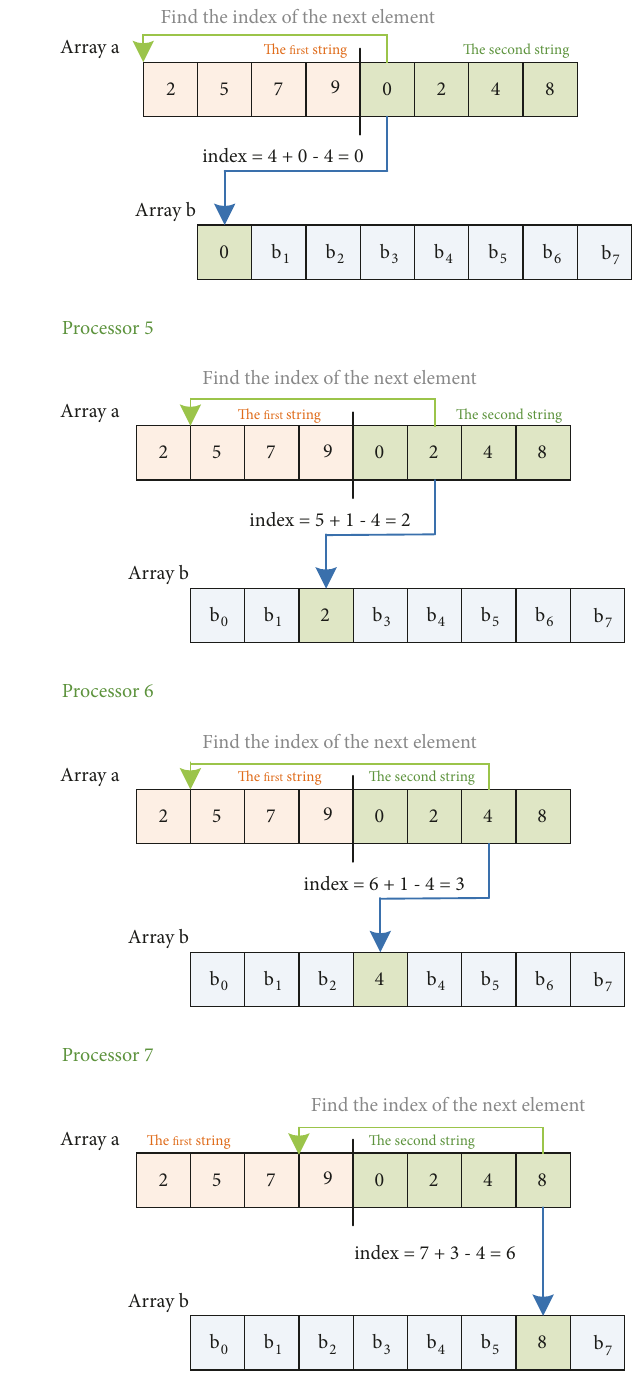
Figure 4: Model of the applied flexible sorting for the number of processors for the insertion of elements into the array b : processor 𝑃 𝑎 𝑃 𝑎 1 sorts element 1 4 sorts element 4 into the array b , processor into the array b , processor 𝑃 6 sorts element 𝑎 6 into the array b ,